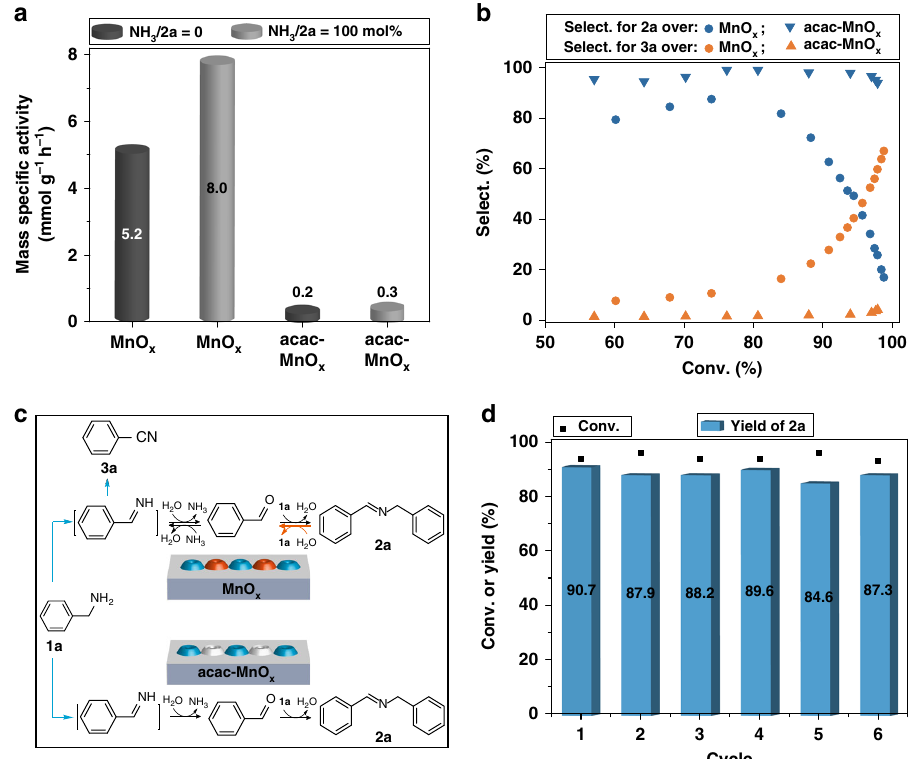
Fig. 3 Reactivity of N -benzylidenebenzylamine ( 2a ) over unmodi fi ed and acac-modi fi ed MnO x . a Mass-speci fi c activities (mmol g cat − 1 h − 1 ) of MnO x and acac-MnO x in aerobic oxidation/ammoxidation of N-benzylidenebenzylamine ( 2a ) under 0.3 MPa O 2 at 90 °C. The mass-speci fi c activity was measured at the reaction time of 1 h when the conversion is below 30%. b Selectivity-conversion correlation of N-benzylidenebenzylamine ( 2a ) in aerobic oxidation of benzylamine under 0.3 MPa O 2 at 90 °C. c Proposed mechanism. d Recyclability test results for selective synthesis of N -benzylidenebenzylamine ( 2a ) by oxidation of benzylamine over acac modi fi ed MnO x . Reaction conditions: 1 mmol benzylamine, 0.1 mmol MnO x , acac/MnO x = 20 mol%, 5 mL CH 3 CN, 0.3 MPa O 2 , 90 °C, 14